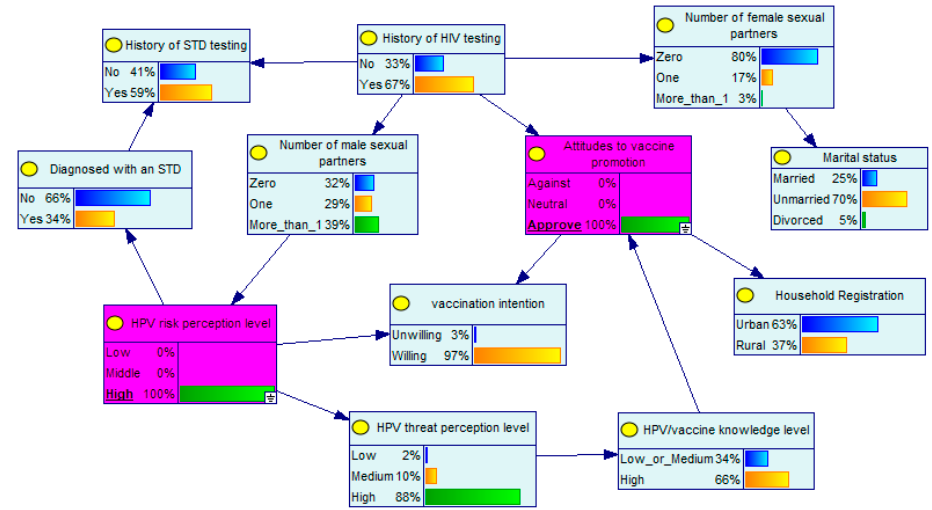
Figure 3. Bayesian network with known node probabilities II.